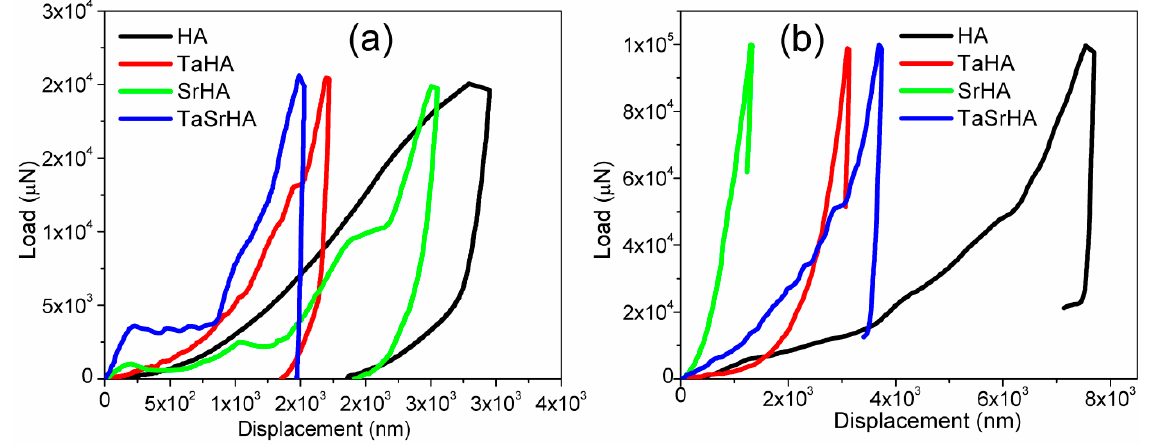
Figure 13. ( a ) Nano indentation for 20 mN load and ( b ) Nano indentation for 100 mN load.